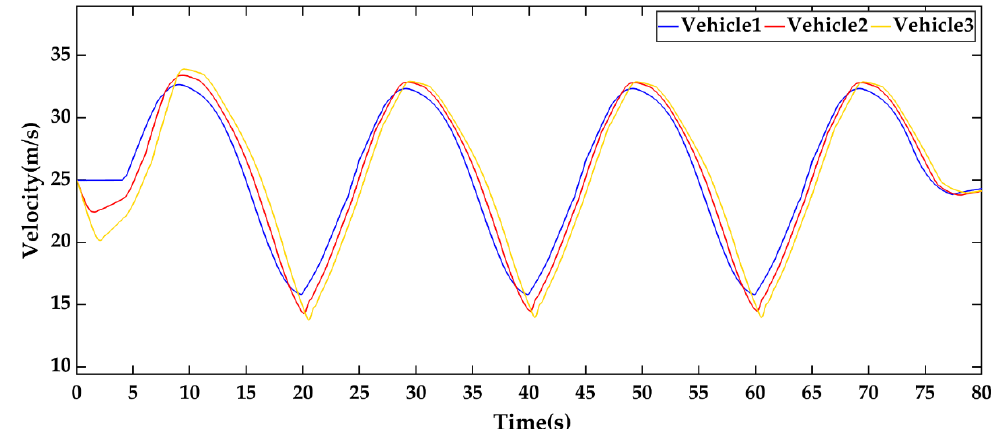
Figure 17. The velocities of the following vehicle under the standard MPC strategy in Scenario 2.